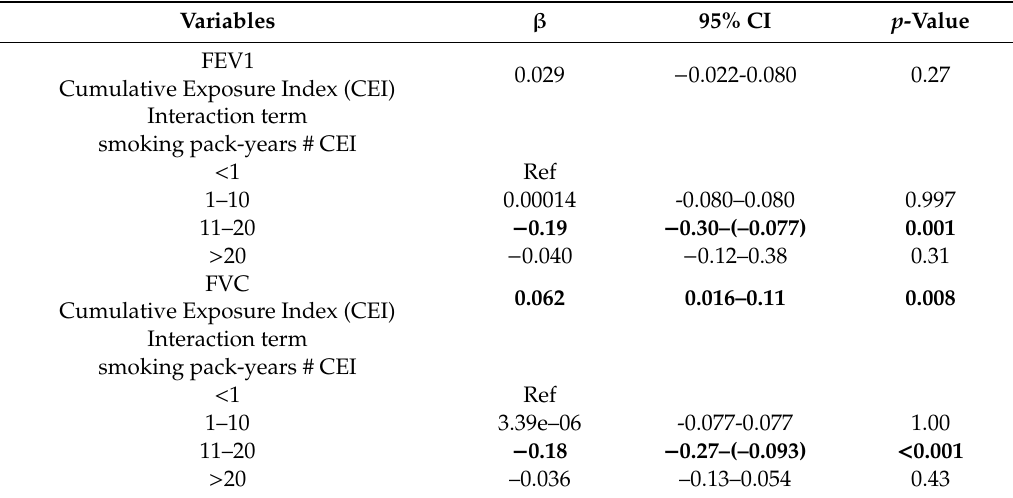
Table 6. Multiple linear regression model of the FEV1 and FVC percent predicted on the cumulative exposure